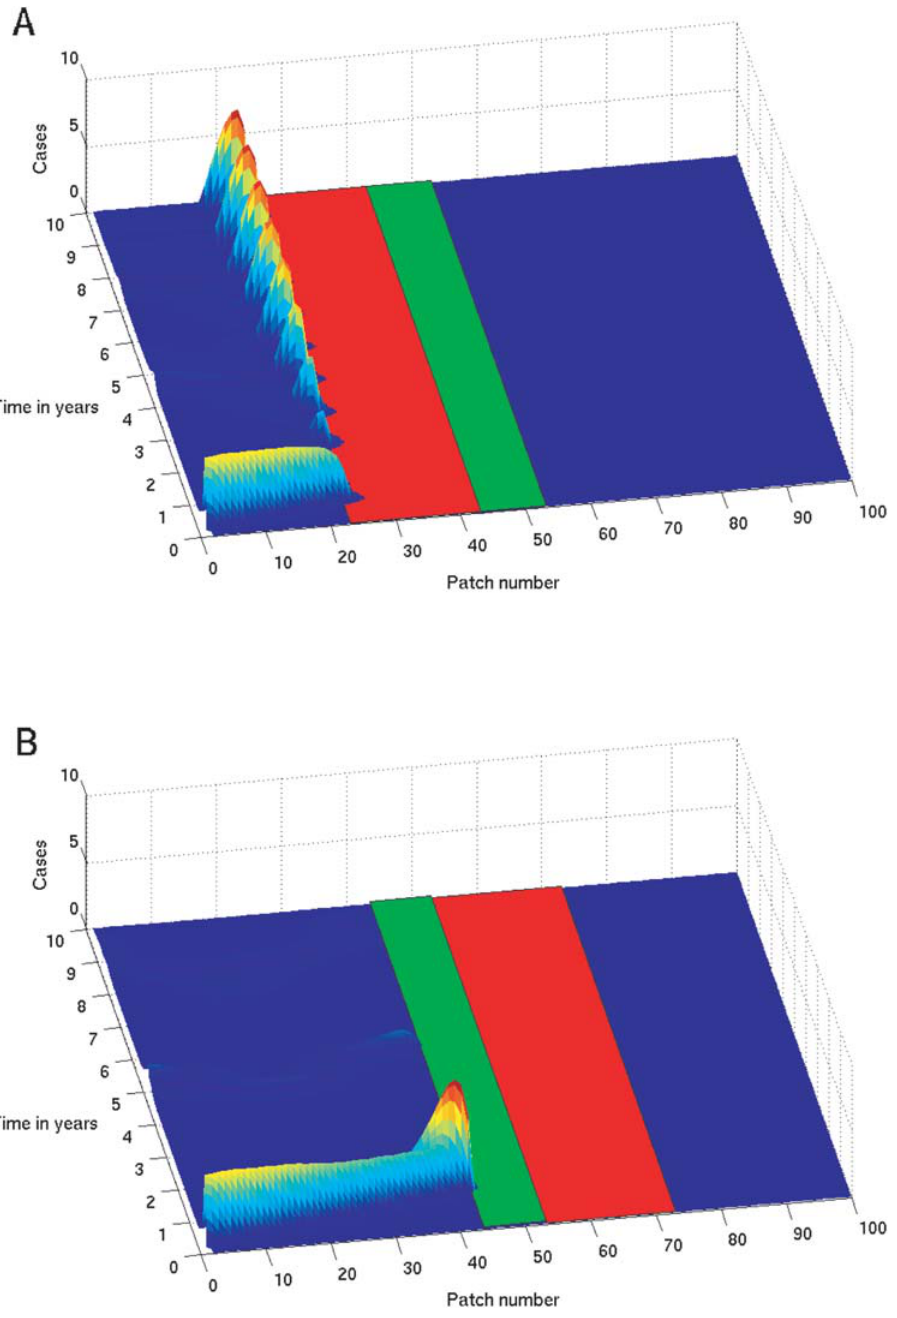
Figure 4. Disease incidence over space and time for simulations with vaccination before the river (a) and after the river (b). The river is represented by the light green bar and the vaccine corridor by the red bar.